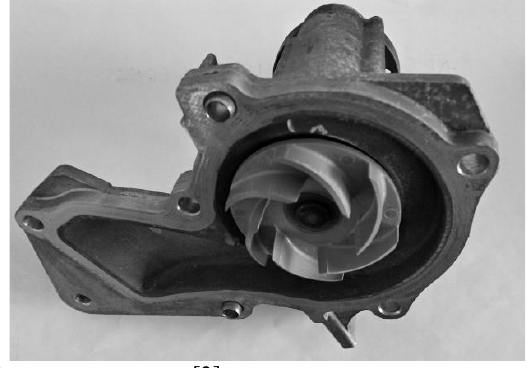
Fig. 1. Radial Impeller [3] Centrifugal pumps are hydrodynamic machines used for transportation of liquids by raising a volume flow to a specified pressure level. The impeller transfers the mechanical energy into kinetic energy necessary to transport the fluid and accelerates it. This causes the static pressure to increase. The fluid exiting the impeller is decelerated in the volute and the following diffuser in order to utilize the greatest possible part of the kinetic, which is transformed into hydraulic energy, for increasing the static pressure. They come at variety of types according to the shape of the impeller. As such they can be divided into 3 general types: radial, which would be used later for CFD purposes, see Fig. 1, semi-axial and axial. By the number of impellers themselves we can further divide them into single/multi-stage pumps, see Fig.